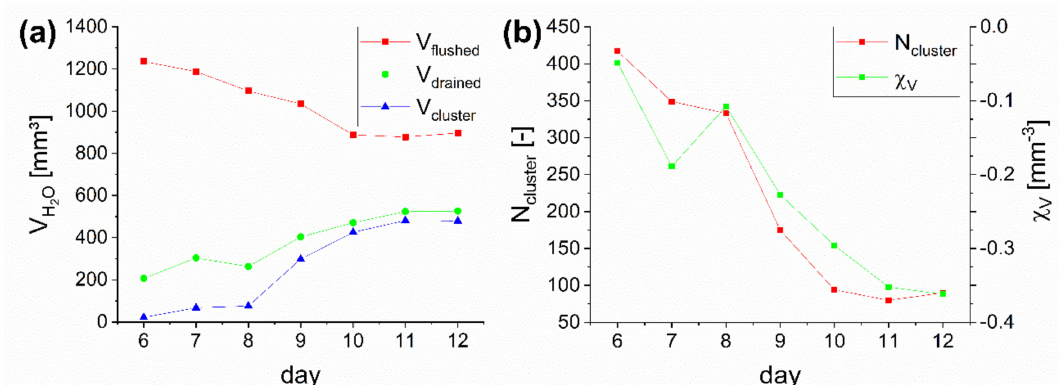
Figure 5. Quantification of water content ( a ) and the total amount of liquid clusters N cluster , as well as the volumetric Euler number χ V ( b ) over time. Water content decreased in the flushed condition, while water retention in the drained condition increased. Furthermore, the connectivity of the liquid phase in the flushed condition increased, as indicated by the volume of the largest cluster ( a ) and the volumetric Euler number ( b